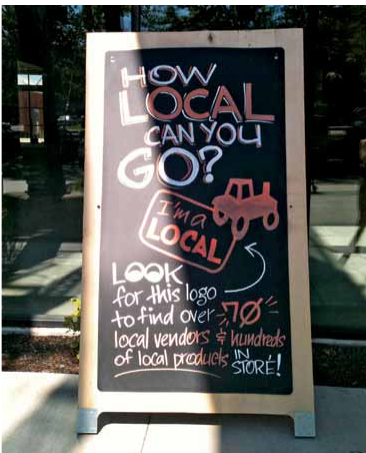
Fig. 7. ‘How local Can You Go?’, outside Whole Foods in Salt lake